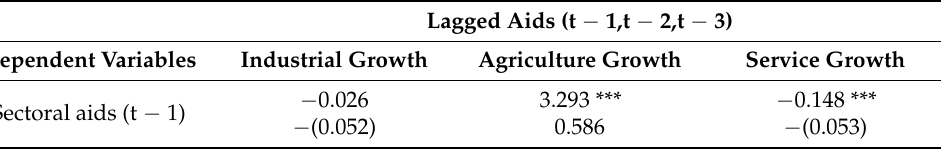
Table A9. Instrumented Aids with Three Lagged Periods and GMM and Pooled OLS Driscoll-Kraay Standard